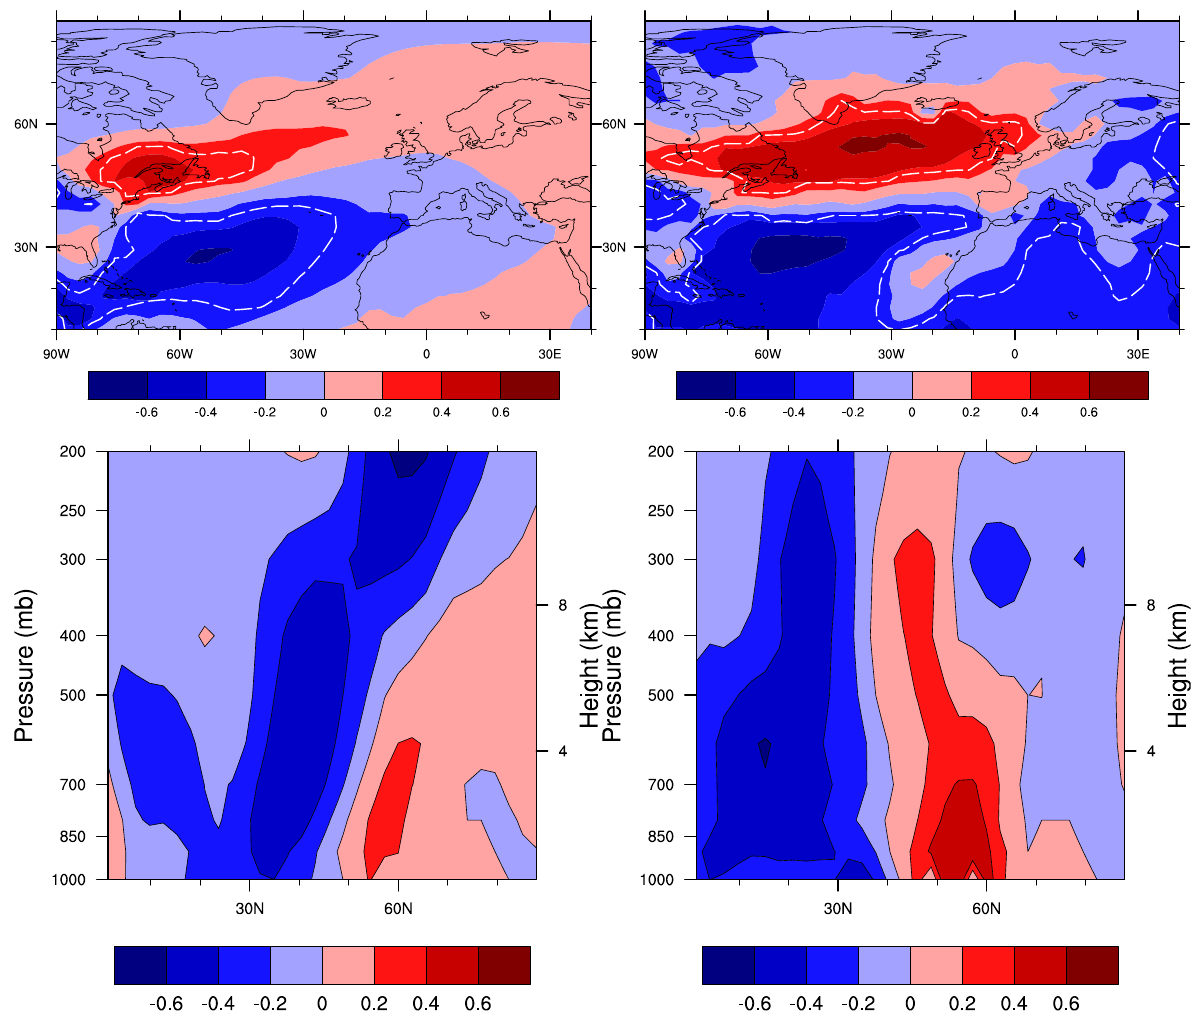
Fig. 7. Correlation of winter (December–February) seasonal surface concentration anomalies (top) and meridional vertical profiles at 30 ◦ W (bottom) with the principal component of the EOF time series of SLP in the North Atlantic sector for gaseous tracers (left) and soluble aerosols (right) emitted from North America. White dashed contour lines indicate the local 95% level of